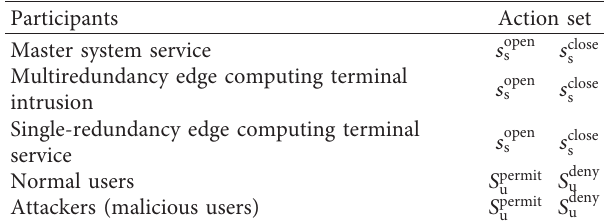
Figure 2: Game-based mimic linkage intrusion detection model. Table 2: Action set of the